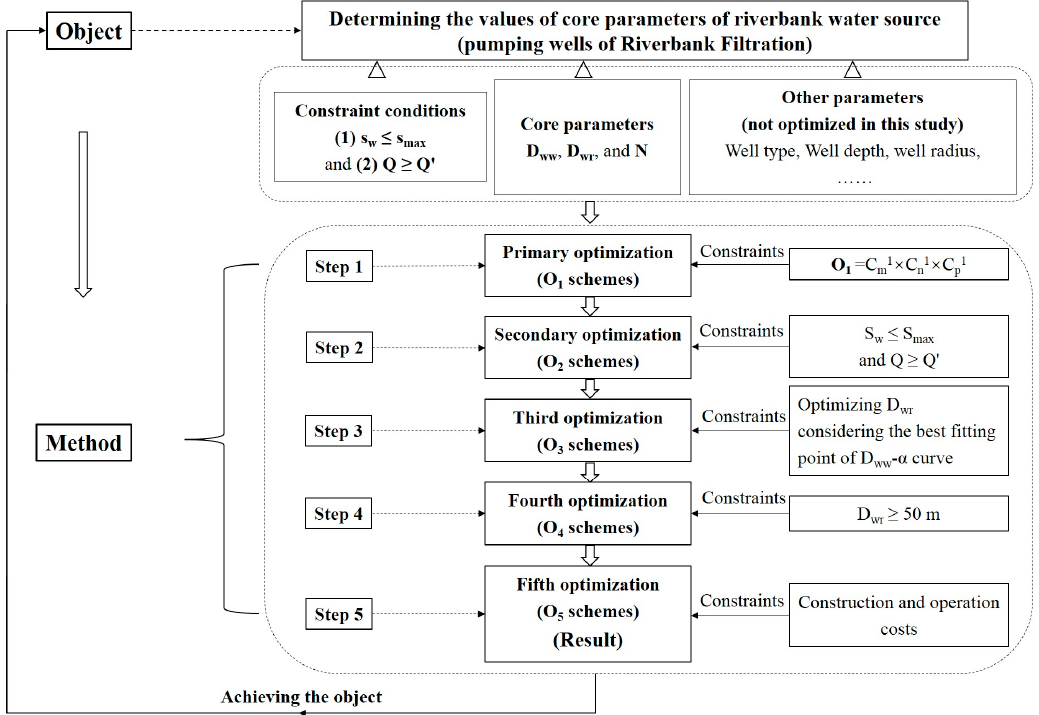
Figure 3. Roadmap of the optimizing method (Five-Step Optimizing Method) established in the study.